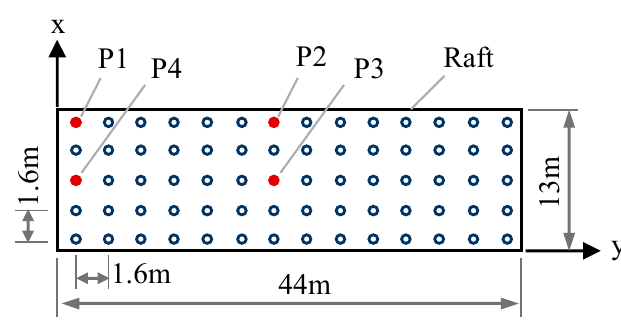
Figure 3. Schematic profile of calculation model.